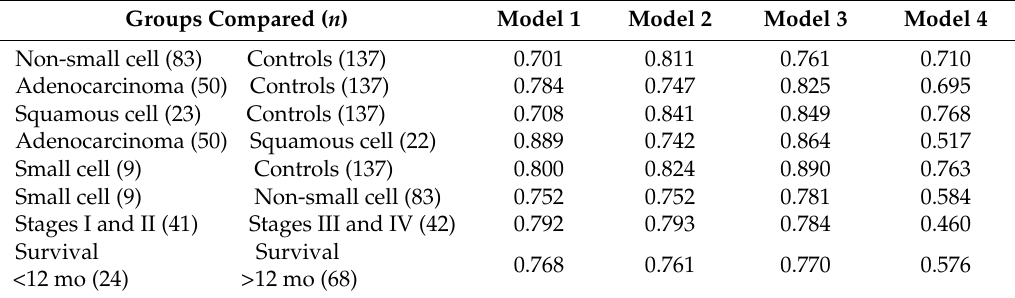
Figure 4. Receiver operating characteristic curves for the most accurate validated models comparing non-small cell carcinoma to controls and for the individual non-small cell carcinoma histologies to controls. Used with permission from [74]. Table 1. Accuracy of Statistically Validated Breath Biosignature Models. Used with permission from [74].